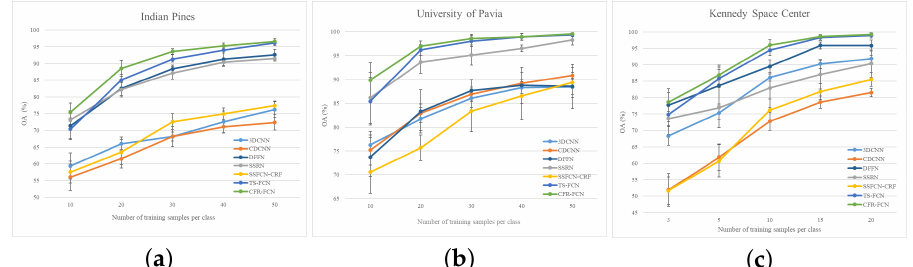
Figure 9. The overall accuracy (OA) of different methods for different numbers of training samples in three HSI data sets. ( a ) Indian Pines. ( b ) University of Pavia. ( c ) Kennedy Space Center.